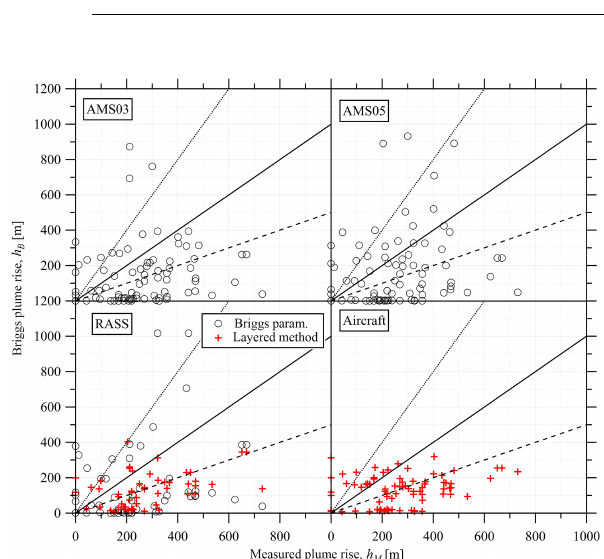
Figure 5. Comparison of the predicted plume rise from the Briggs parameterization used in GEM-MACH with the measured plume rise as determined by various atmospheric measurements described in the text. Black circles indicate the Briggs parameterization (Eqs. 1–6) and red crosses indicate the layered method (Eq. 7). Lines demonstrate 2 : 1 (dotted), 1 : 1 (solid), and 1 : 2 (dashed) ra- tios for